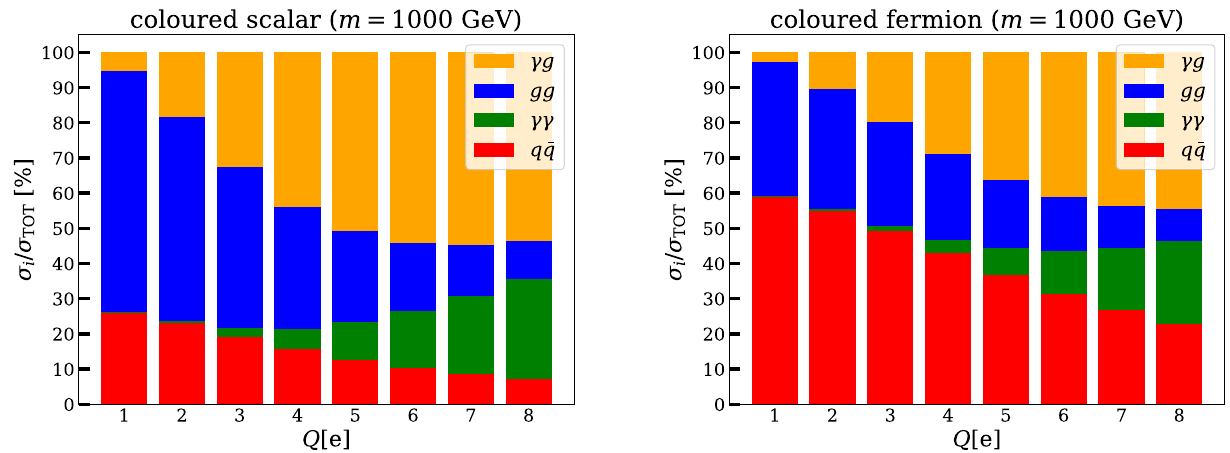
Fig. 5 Contributions of various initial states, q ¯ q (red), γγ (green), gg (yellow), γ g (blue), to the production rate of coloured scalars (left) and fermions (right) with m = 1